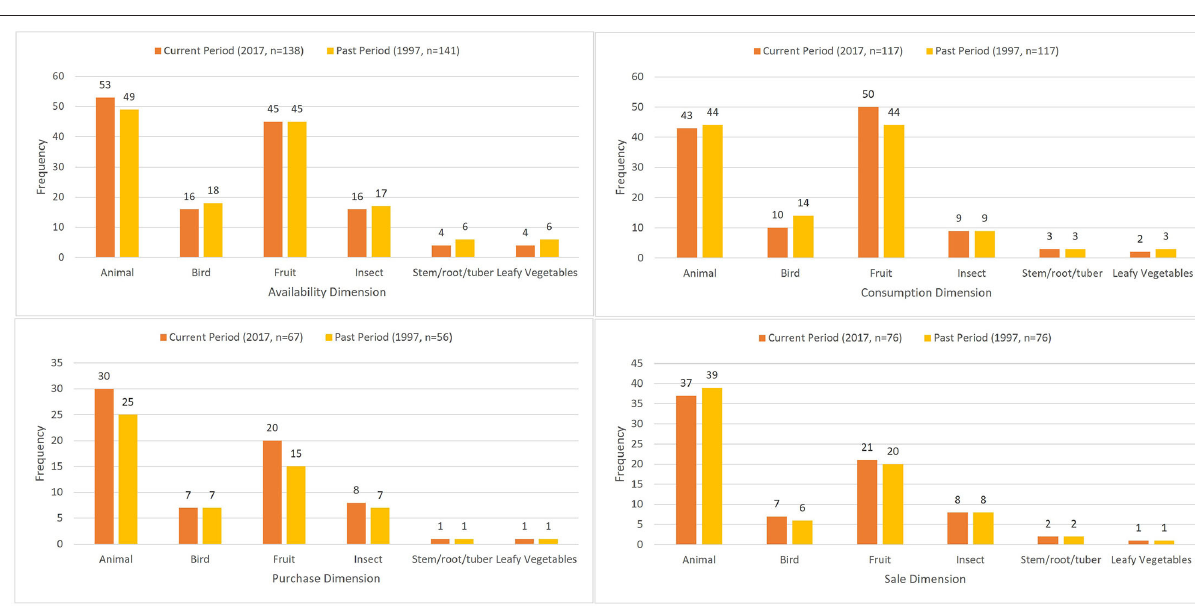
FIGURE 9 | Frequency of wild species according to the 4-dimension in Acholi sub-region (availability, consumption, purchase, and sale) ( Supplementary Table 2